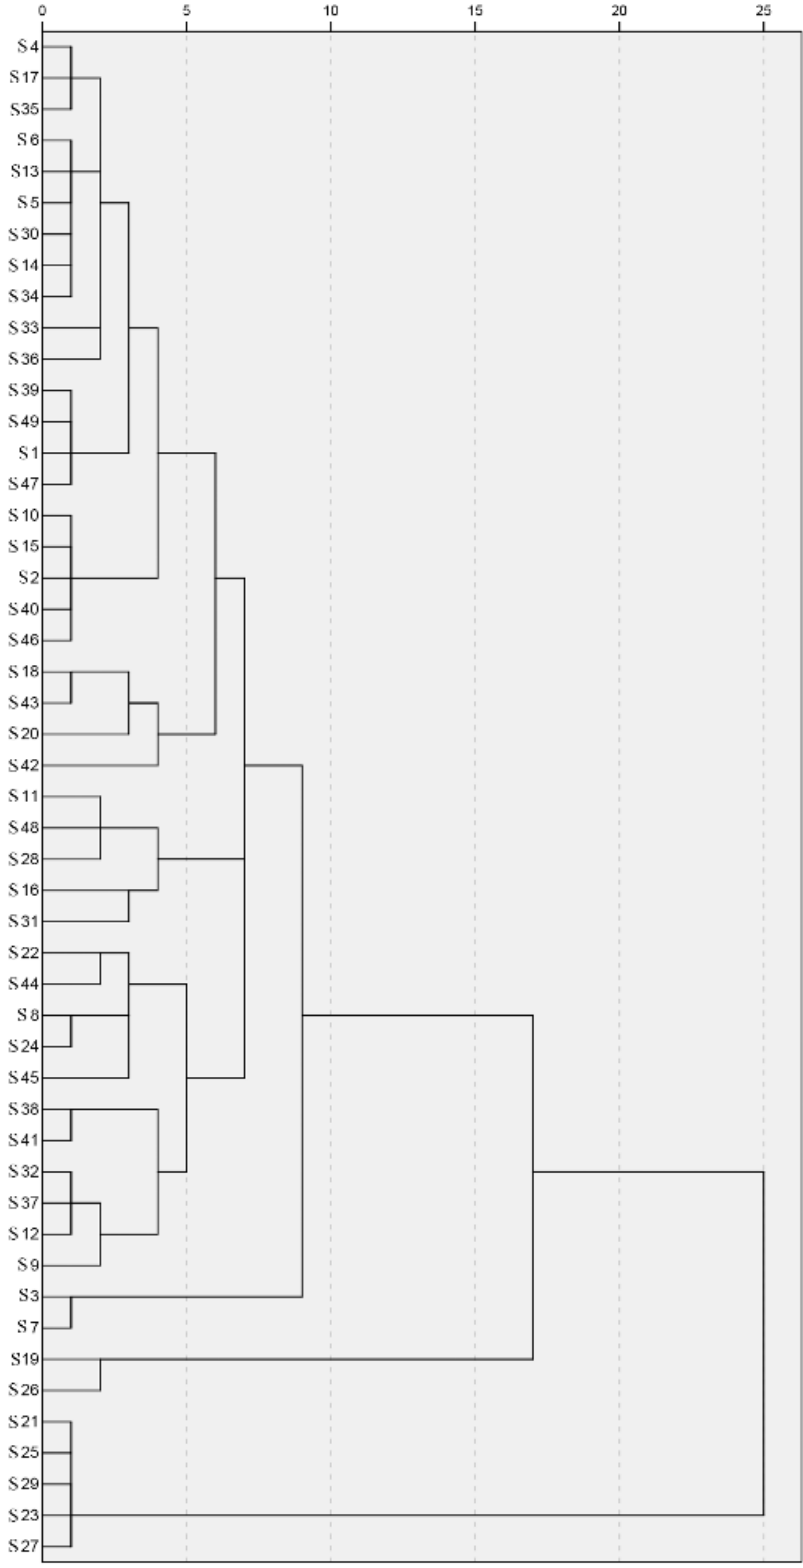
Figure 2. Dendrogram of cluster analysis of 49 Chinese propolis samples (S1–S49).